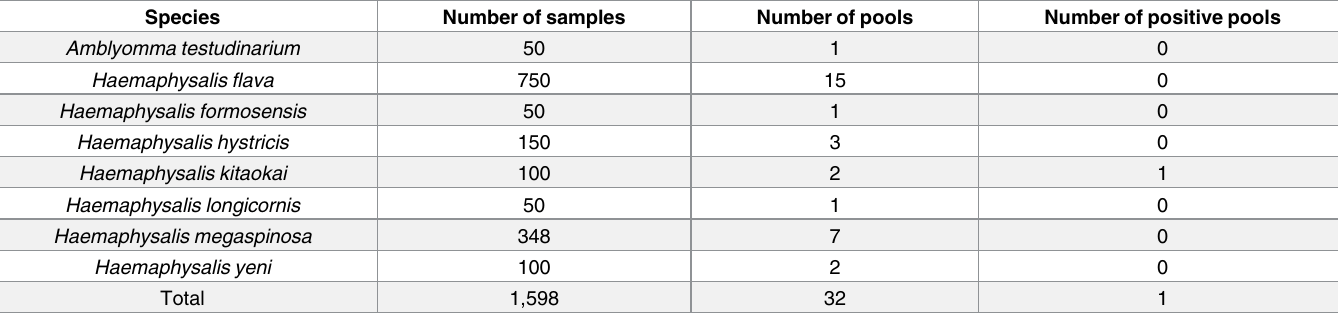
[15]. qPCR was performed in a final volume of 12.5 μl for tick and 25 μl for wild animal sam- ples. The amplification conditions were as follows: 95˚C for 20 s followed by 45 cycles at 95˚C for 1 s and 60˚C for 20 s. The threshold line was fixed at 0.2 to avoid detecting nonspe- cific fluorescence. Table 3. Larval ticks prepared from engorged females collected from wild boar or sika deer in Shimonoseki, Yamaguchi Prefecture.